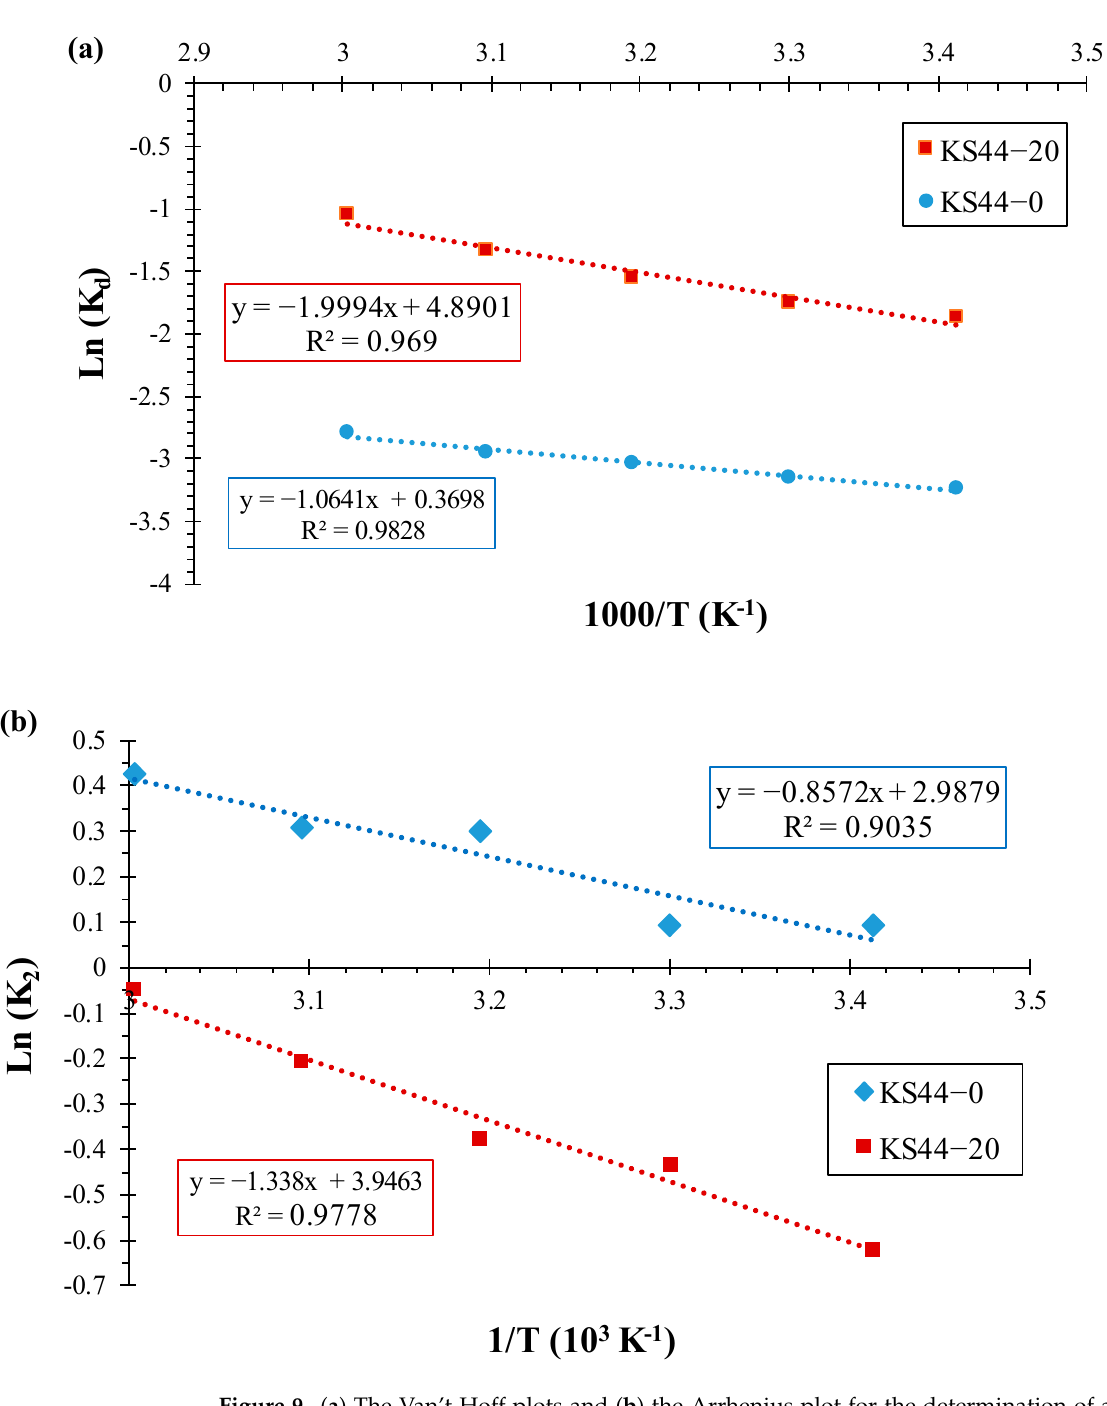
Figure 9. ( a ) The Van’t Hoff plots and ( b ) the Arrhenius plot for the determination of activation energy for adsorption of RhB on KS44-0 and KS44-20 at different temperatures. Table 5. Thermodynamics parameters for the adsorption of RhB onto KS44-0 and